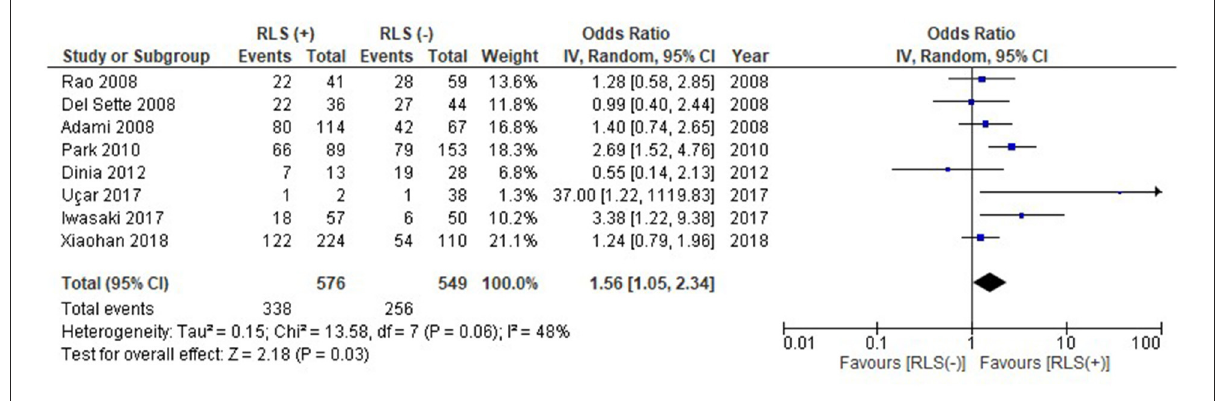
FIGURE2 Forest plot of the association of RLS with prevalence of WMH (odds